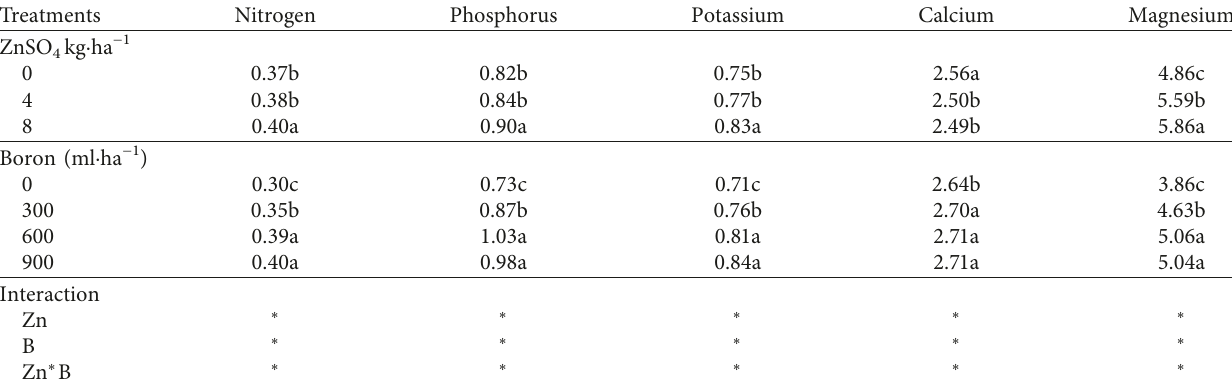
Table 5: Effects of Zn and B fertilizers on the nutrient content (mg · kg − 1 ) of groundnut seeds (pooled data of 2016 and 2017 cropping seasons).